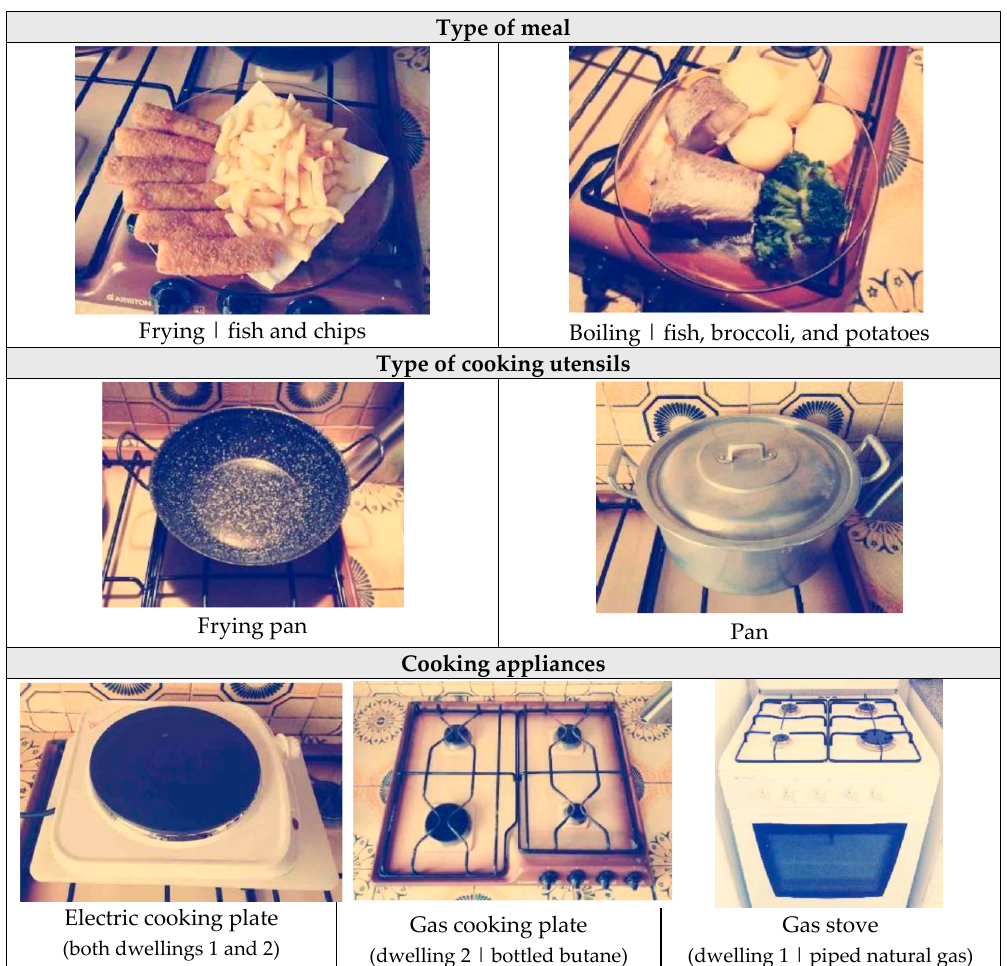
Figure 3. Type of meals prepared and cooking utilities and appliances used.